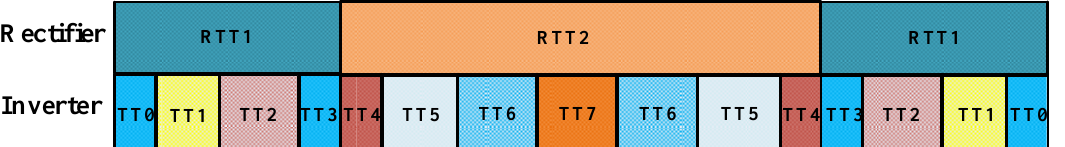
Figure 4. Zero-current switching sequence.